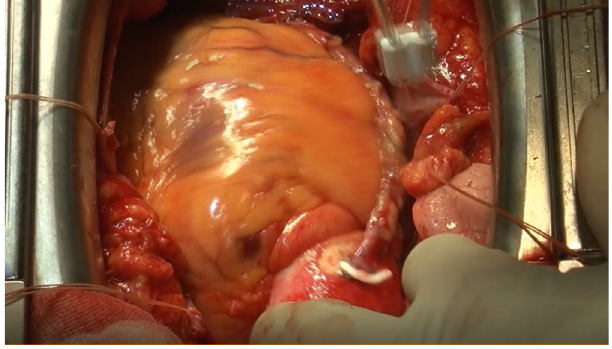
Fig. 4 - “No-touch” saphenous vein graft was attached to the epicardium using fibrin